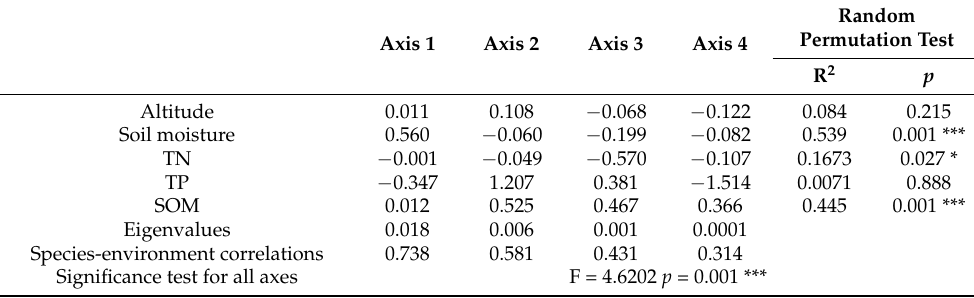
F = 4.6202 p = 0.001